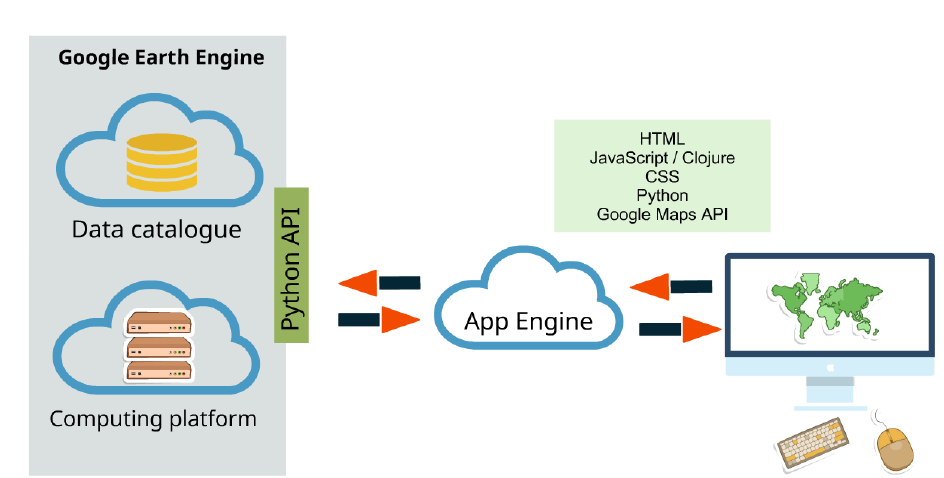
Figure 3. The infrastructure for spatial application development provided by Google. GEE consists of a cloud-based data catalogue and computing platform. The App Engine framework was used to serve the data to a web browser and communicate with the GEE using the Python API. Figure reused with permission from Poortiga et al.